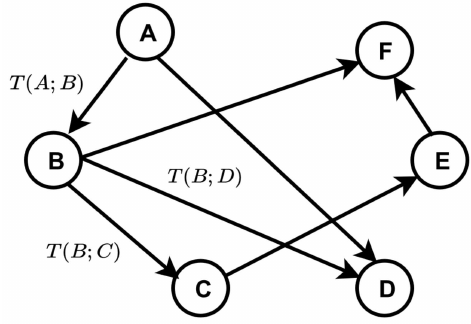
Figure 1. Directed-weighted process graph.